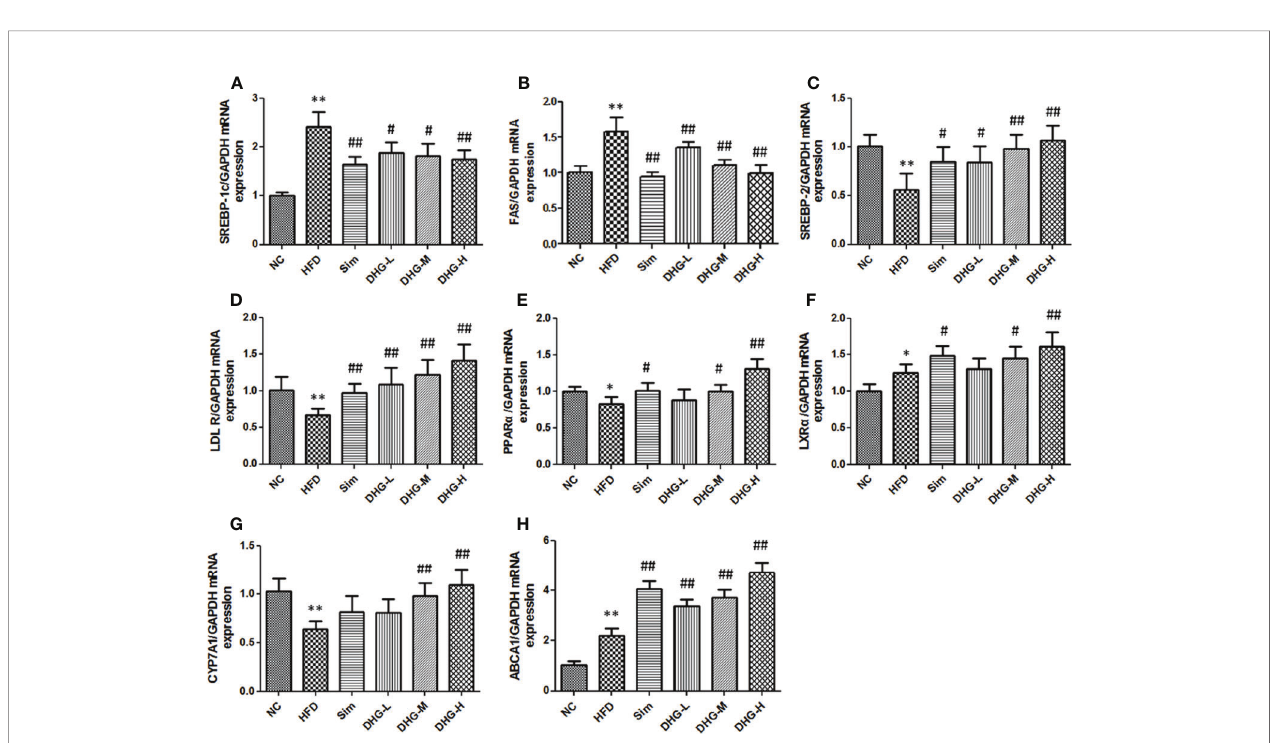
FIGURE 6 | Effect of DHG on mRNA expression of genes in hamster liver by RT-PCR. Values are mean ± SD, n = 5. (A) SREBP-1c mRNA. (B) FAS mRNA. (C) SREBP-2 mRNA. (D) LDLR mRNA. (E) PPAR a mRNA. (F) LXR a mRNA. (G) CYP7A1 mRNA. (H) ABCA1 mRNA. RT-PCR, real-time polymerase chain reaction; SREBP-1c, sterol regulatory element-binding protein-1c; FAS, fatty acid synthase; SREBP-2, sterol regulatory element binding protein 2; LDLR, low density lipoprotein receptor; PPAR a , peroxisome proliferation-activated receptor alpha; LXR a , liver X receptor alpha; CYP7A1, cholesterol 7 a -hydroxylase; ABCA1, ATP binding cassette subfamily A member 1. * p < 0.05 vs NC; ** p < 0.01 vs NC; # p < 0.05 vs HFD; ## p < 0.01 vs